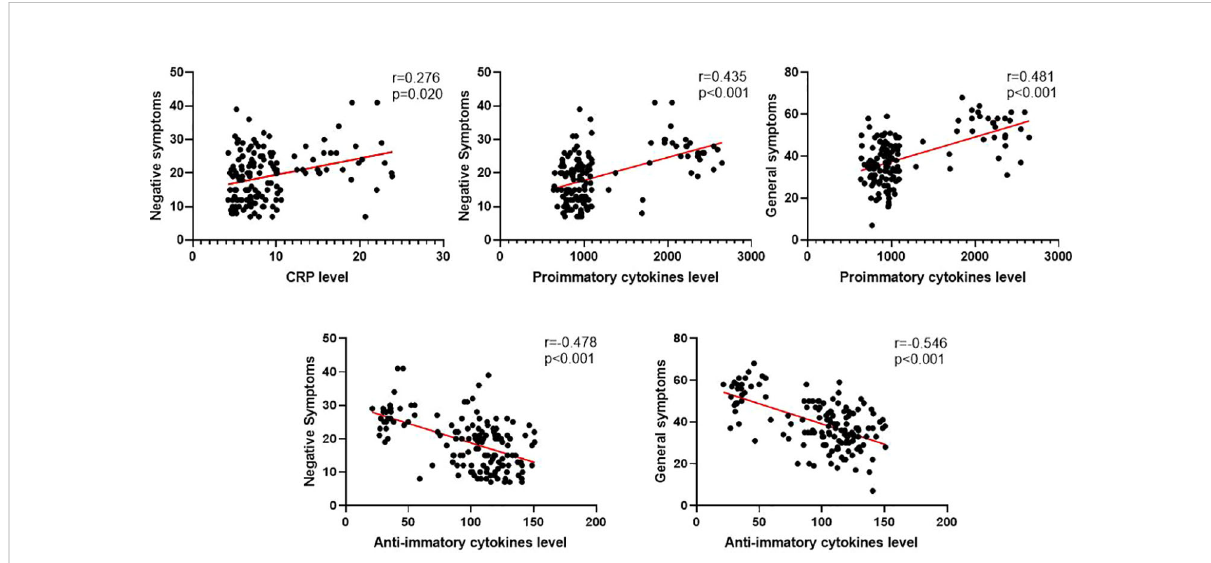
FIGURE 2 Signi fi cant correlation between cytokines and various clinical symptoms in SCZ